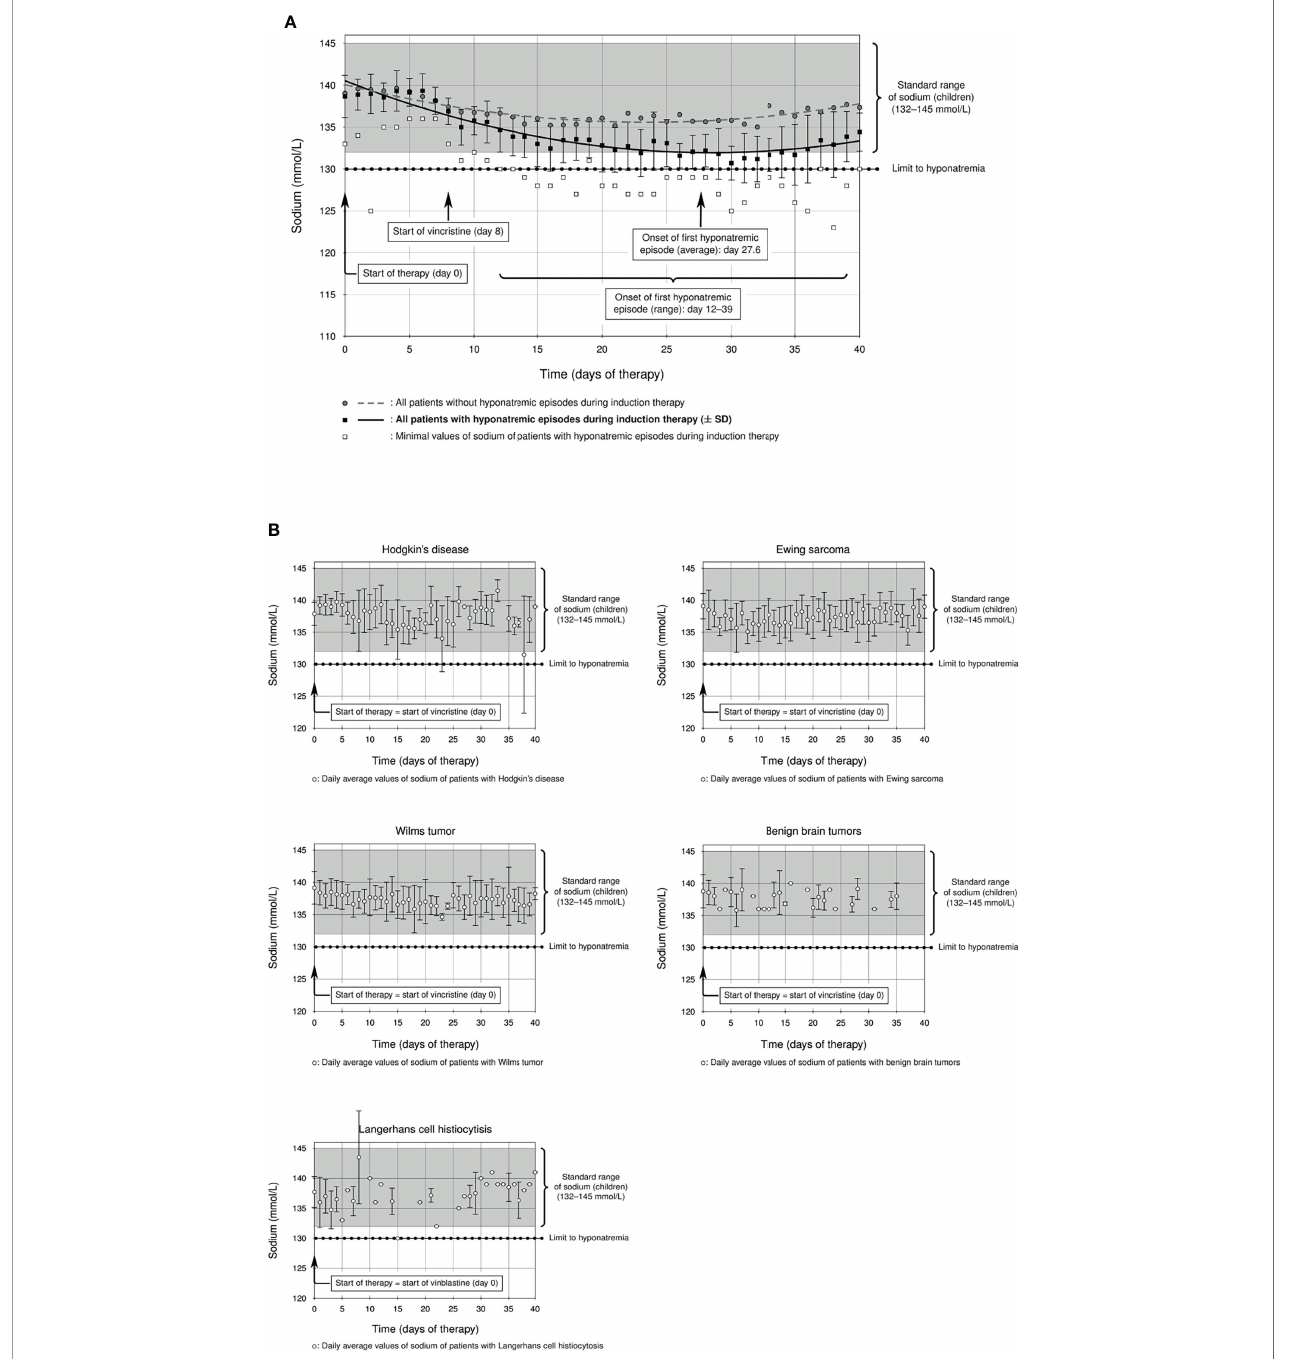
FIGURE 2 | (A) Prevalence of hyponatremia in the studied ALL cohort: a considerable group of ALL patients showed statistically signi fi cant hyponatremia during induction therapy (solid line, ± standard deviation) compared to the rest of the ALL cohort (dashed line), which remained within the standard range of sodium in childhood (132 – 145 mmol/l). The start of the fi rst hyponatremic episode was on average between days 27 and 28 (average day 27.6, curly brackets), although there was a statistically signi fi cant difference between hyponatremic and non-hyponatremic patients from day 12 (p = 0.014, F test and T test, curly brackets). (B) Mean sodium levels of all patients with the following diagnoses during the fi rst 40 days of their initial therapy. Patients with Hodgkin ’ s lymphoma, Ewing sarcoma, Wilms tumor, benign brain tumors, and Langerhans cell histiocytosis do not show hyponatremia during therapy with alkaloids (sodium levels within standard